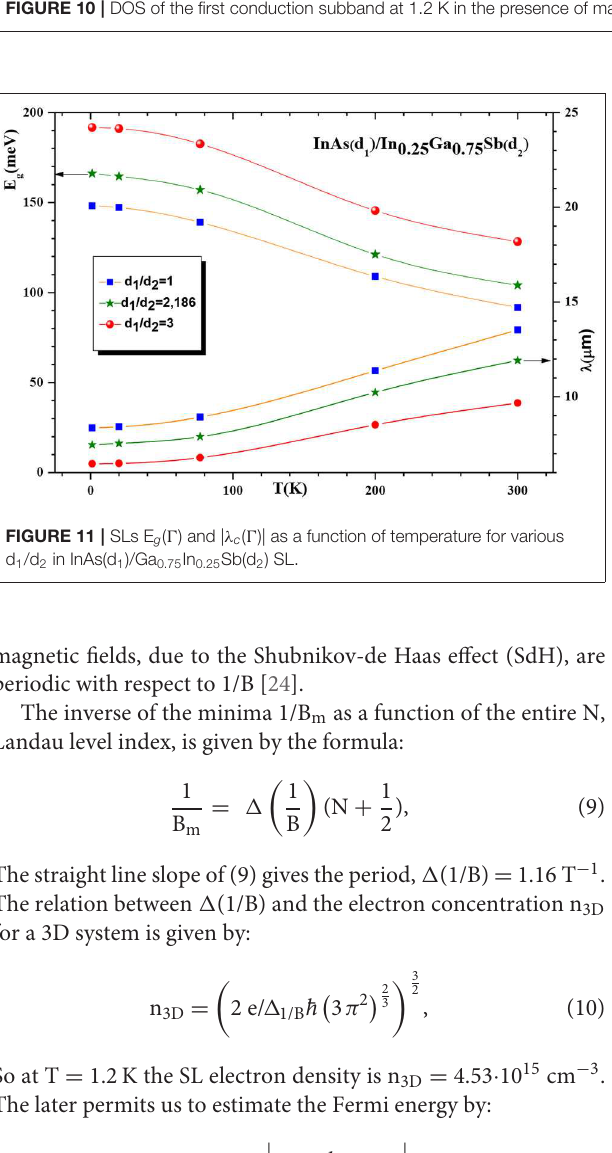
FIGURE 10 | DOS of the first conduction subband at 1.2 K in the presence of magnetic field B.